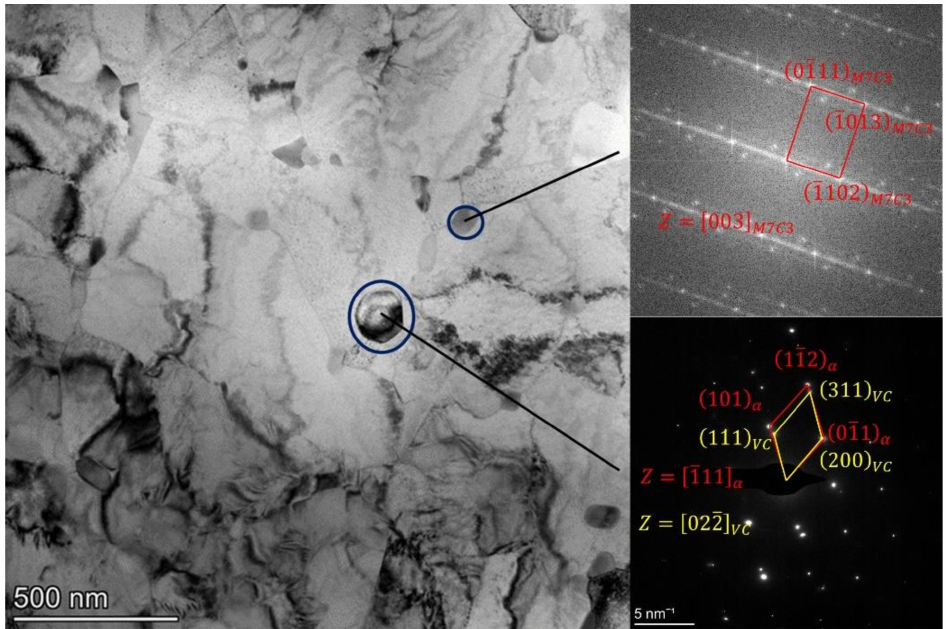
Figure 7. The precipitation and the selected area electron diffraction pattern of